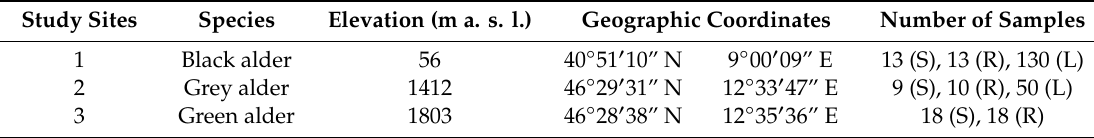
Table 1. Study sites information and number of stem ( S ), rhizosphere ( R ) and leaf ( L ) samples used for Phytophthora